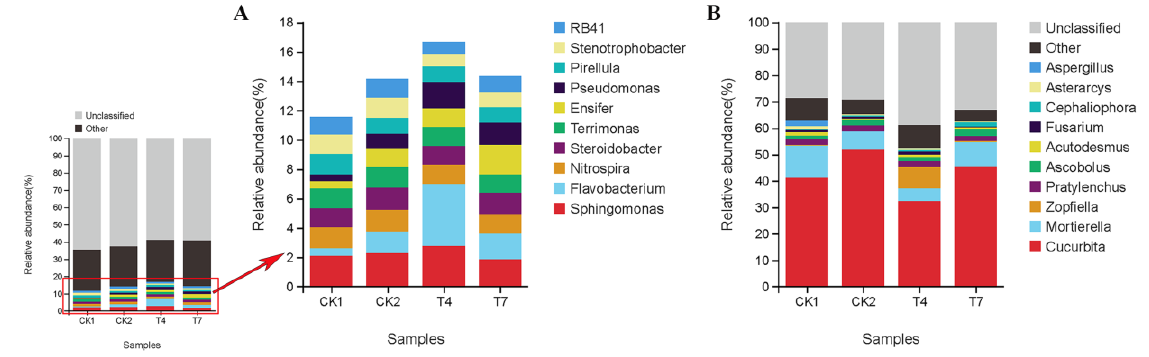
Figure 5. Composition and relative abundances of bacterial ( A ) and fungal ( B ) taxa at the genus